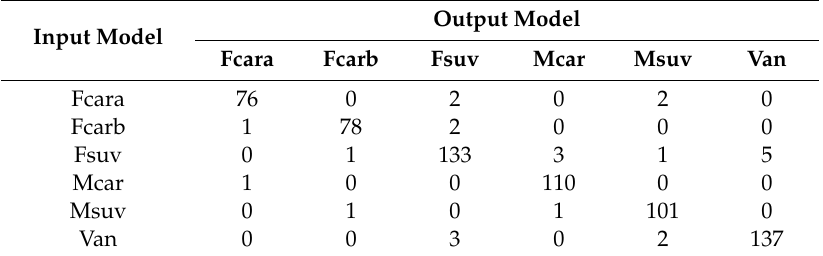
Table 3. The total confusion matrix for the recognition results of all images in an experiment.